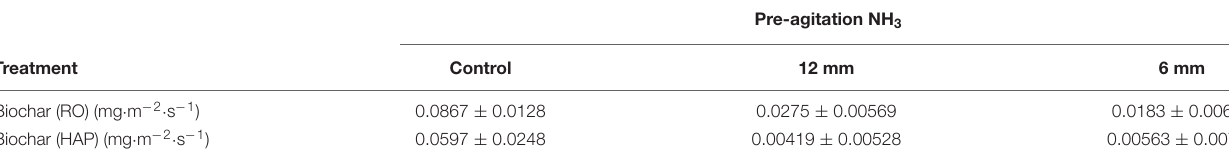
FIGURE 1 | The proof-of-the-concept mitigation of acute NH 3 emissions from swine manure with a surficial application of biochar powder immediately prior to agitation. TABLE 1 | NH 3 emissions after (RO, red oak and highly alkaline and porous, HAP) biochar application (6 or 12 mm surficial dose) to manure surface and before